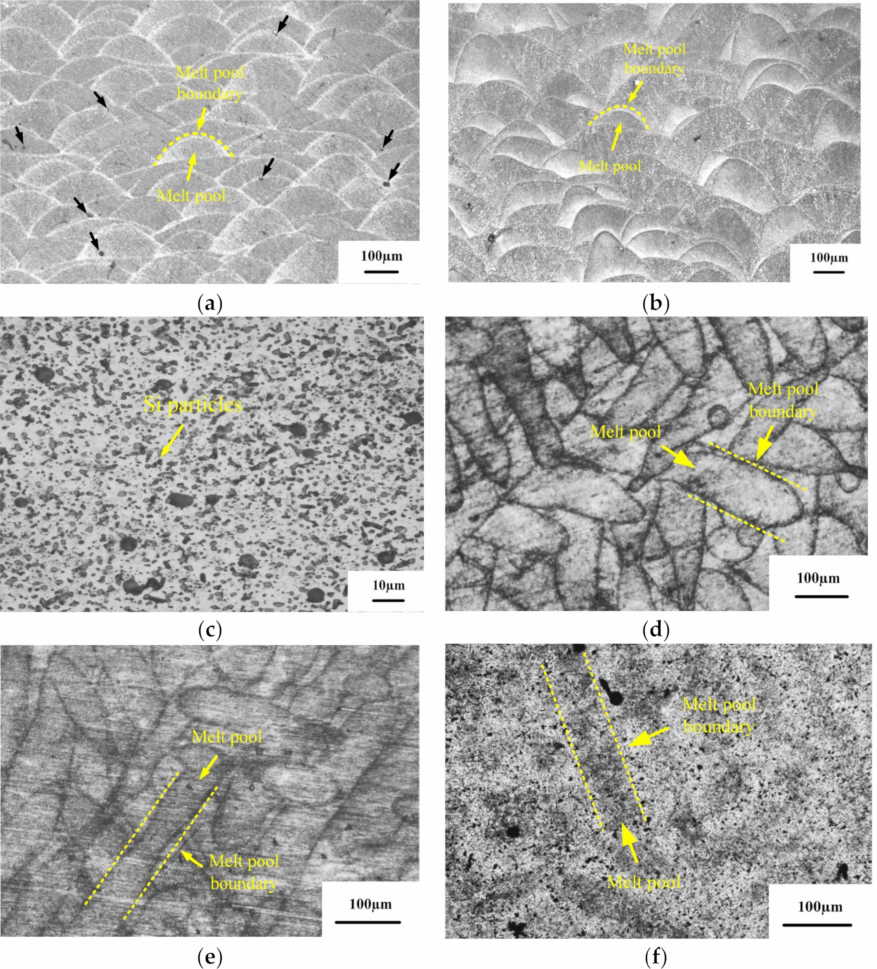
Figure 6. Microstructure of SLM 6061 aluminum alloy samples under different heat-treatment methods: ( a ) deposited, in X–Z direction; ( b ) annealing state, in X–Z direction; ( c ) solution and aging state, in X–Z direction; ( d ) deposited, in X–Y direction; ( e ) annealing state, in X–Y direction; ( f ) solution and aging state, in X–Y